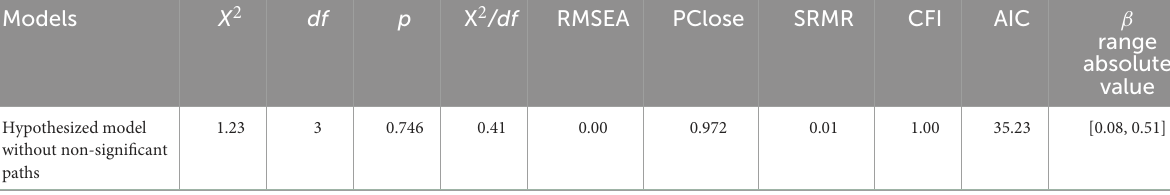
TABLE 3 Model adequacy and goodness of fit indices of the final model.